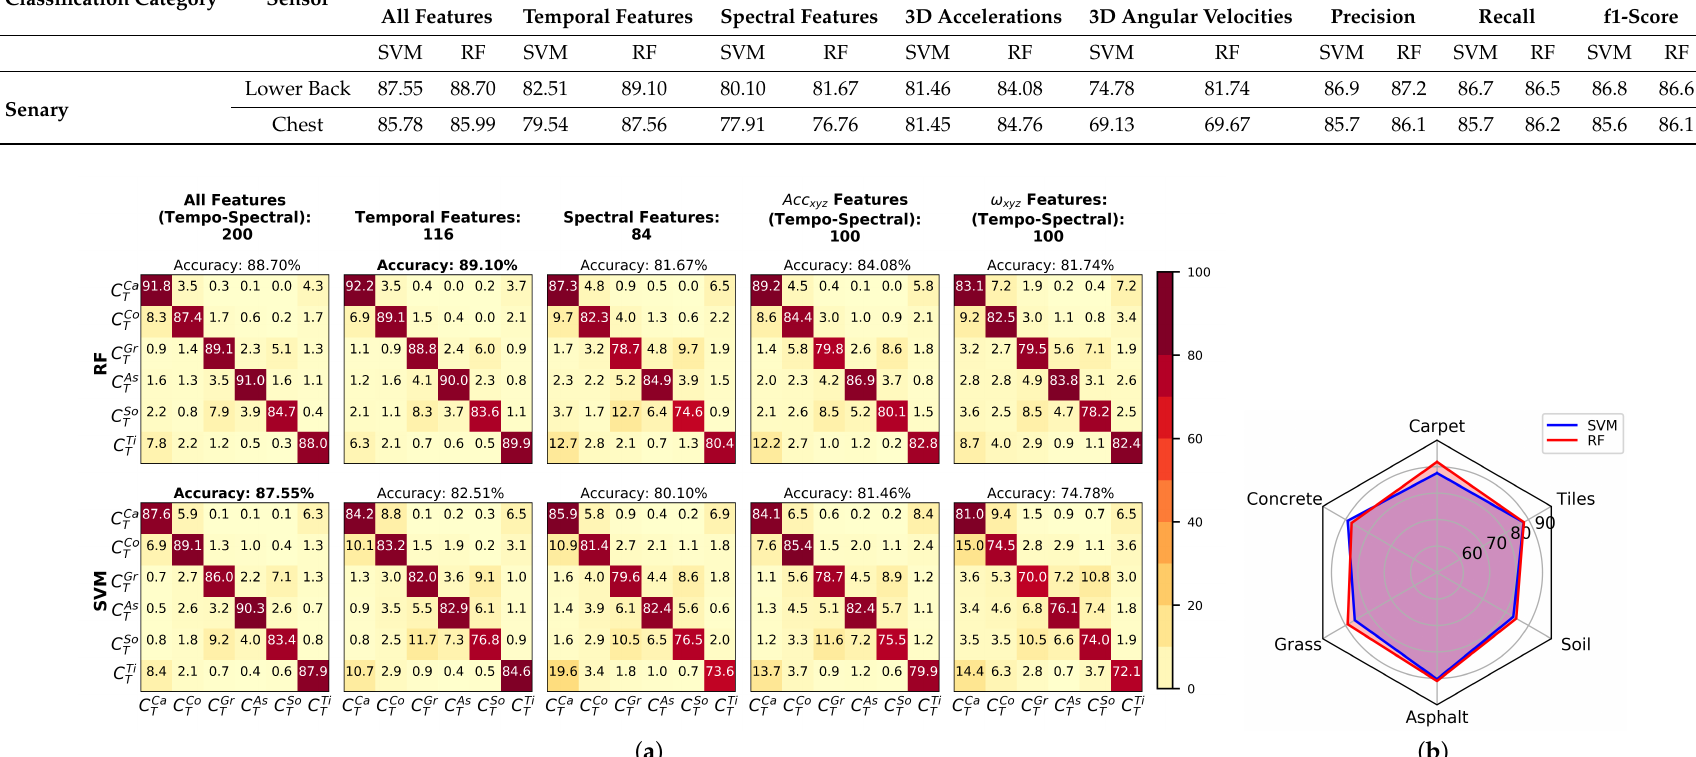
Figure 8. ( a ) Confusion matrices of senary classification with lower back sensor. All results were obtained with all features set (194 features) using SVM classifier. = concrete , C Gr = grass , C As = Asphalt , C So = soil , and C Ti = tiles . ( b ) Radar plot of senary classification = carpet , C Co Classes: C Ca T T T T T T